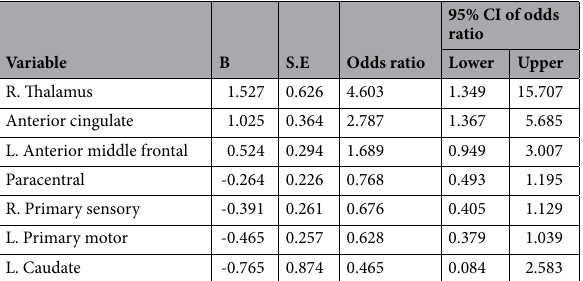
Table 5. Logistic regression results of significant difference areas of volume between the higher and lower MI groups. Odds ratio estimates for logistic regression model variables. R = right, L = left.